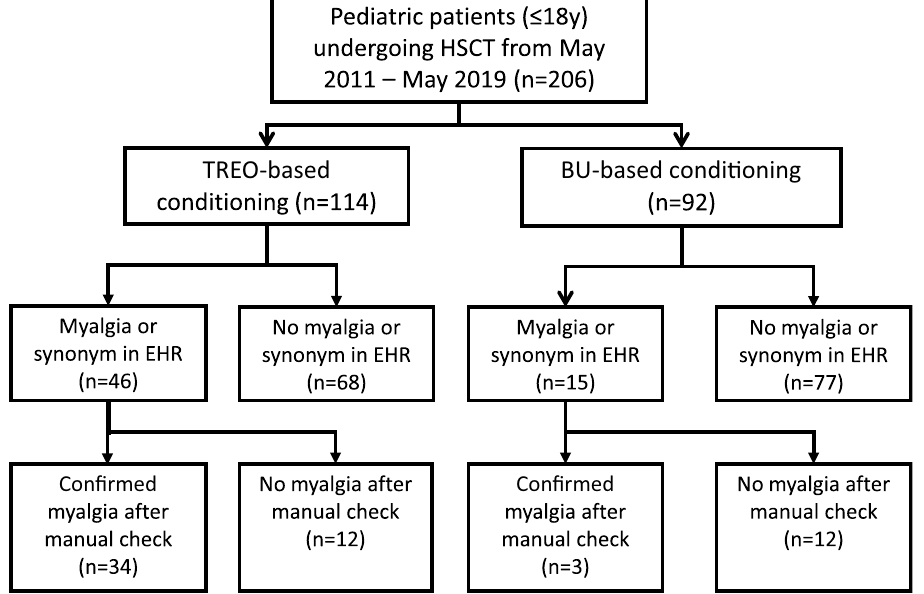
Figure 1. Study design. HSCT Hematopoietic stem cell transplantation, TREO treosulfan, BU busulfan, EHR Electronic Health